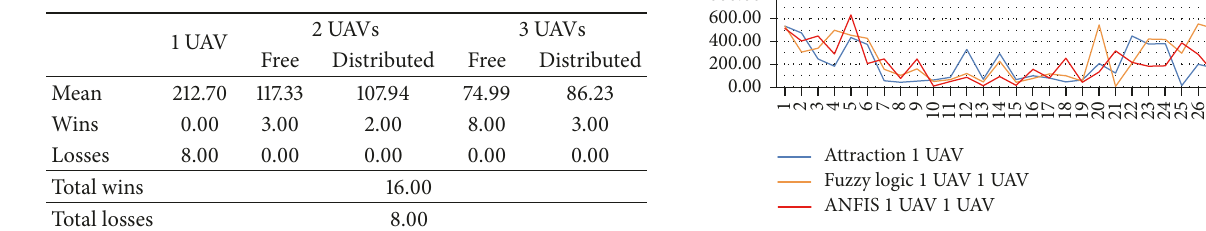
Table 10: Time results with ANFIS path planning.